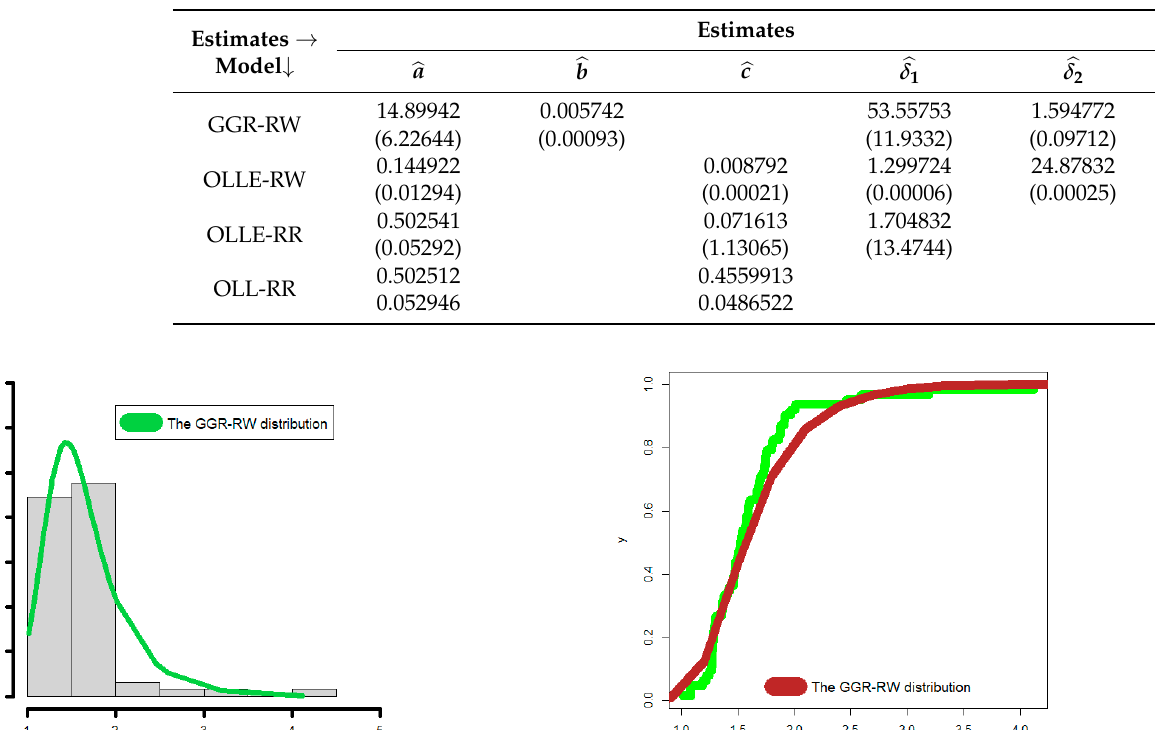
Table 5. MLEs and SEs for the glass fibers data.